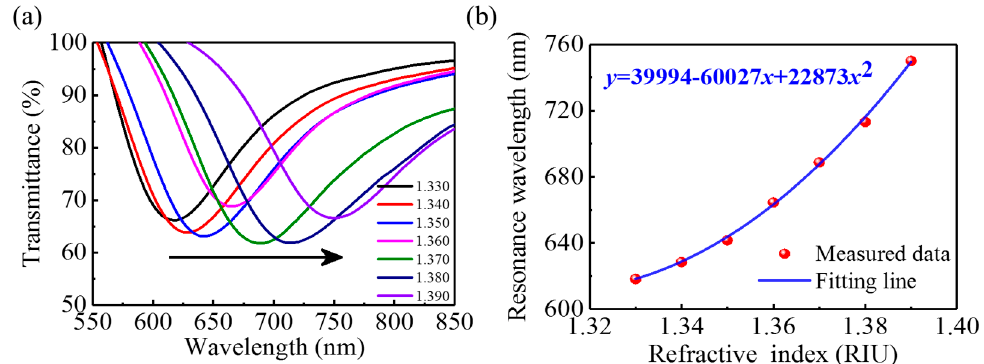
Figure 4. ( a ) Spectral response of the surface plasmon resonance (SPR) sensor to refractive index (RI). ( b ) Measured resonance wavelength as a function of RI.